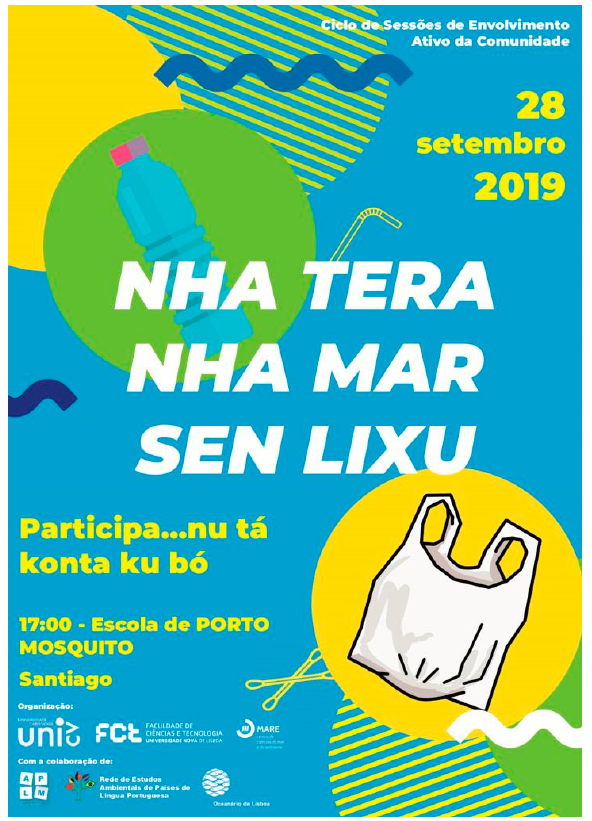
Figure A2. Example of poster for publicizing the sessions, posted in public places in both communities prior the participatory sessions.